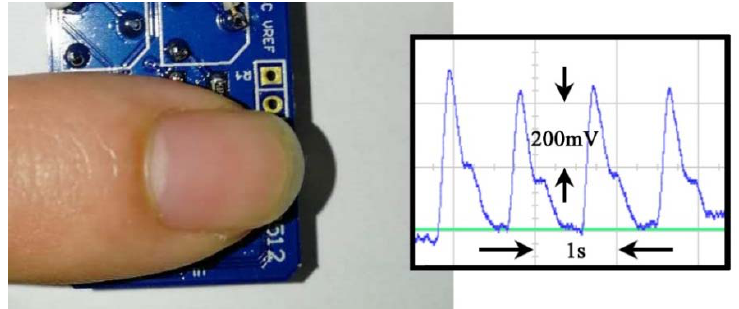
Figure 15. The output PPG signal measured on the finger.